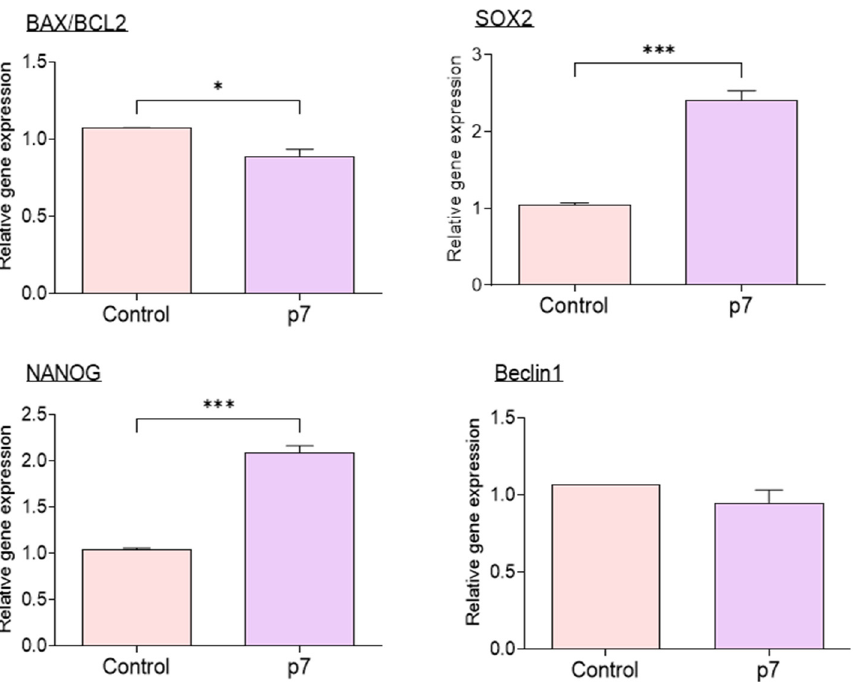
Figure 7. Relative expression of apoptosis-related genes (BAX, BCL2), pluripotency genes (SOX2, NANOG), and autophagy related genes (Beclin1) in blastocysts. The asterisks represent significantly different when compared to the control (*: p < 0.05, ***: p < 0.001).